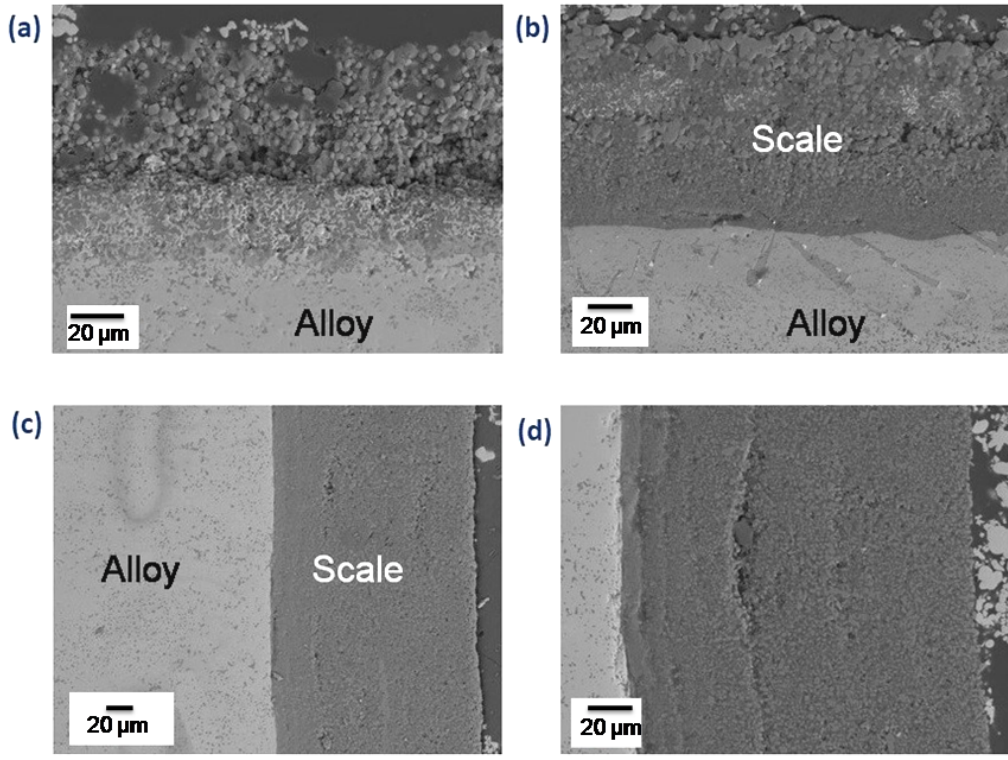
Figure 4: Cross-sectional BSE images of the Mo-Ti-Si composite oxidized at 1300 ∘ C in air for (a) 0.5 h, (b) 5 h, (c) 25 h and (d) 50 h.